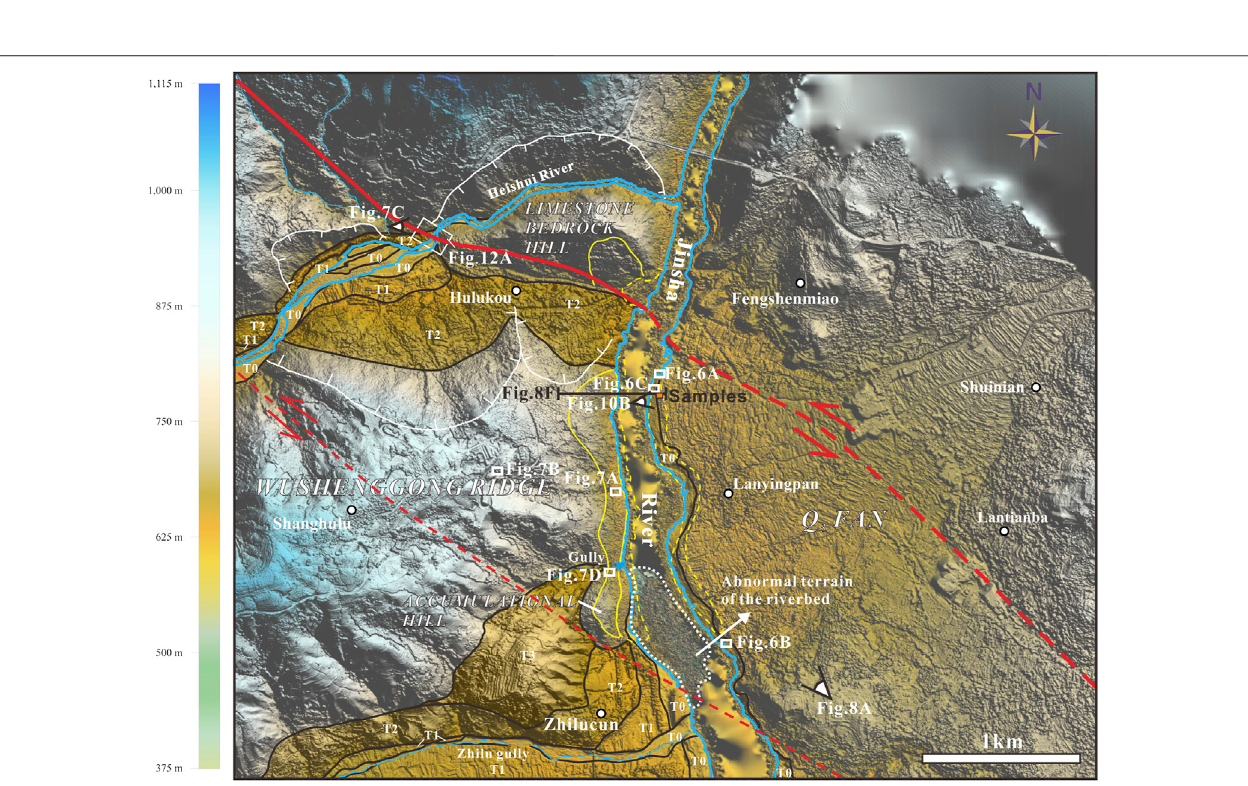
FIGURE3| Cross-sectionofQiaojiaBasin,showingthethreeterracesoftheJinshaRiveranda fl oodplatformbehindthem;fromthedrilldataofLietal.(2016);see the location of the drills in Figure 1 .